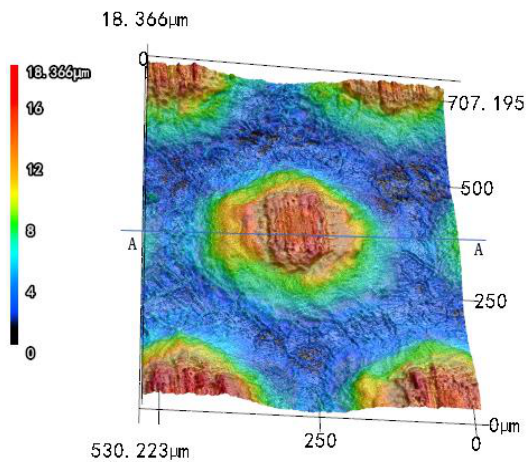
Figure 13. Three-dimensional morphological view of laser-ablated tab (number of processes n = 1).